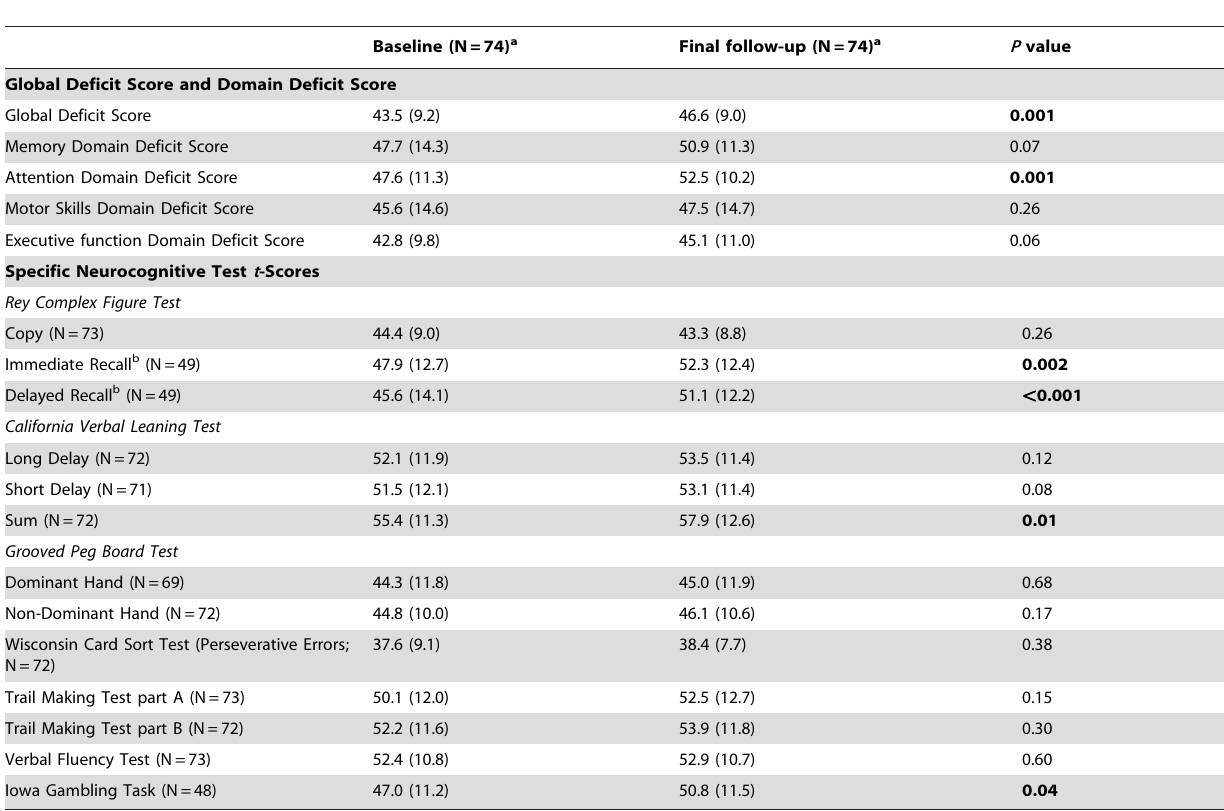
Table 2. Changes in neurocognitive functions between the first and the final follow-up